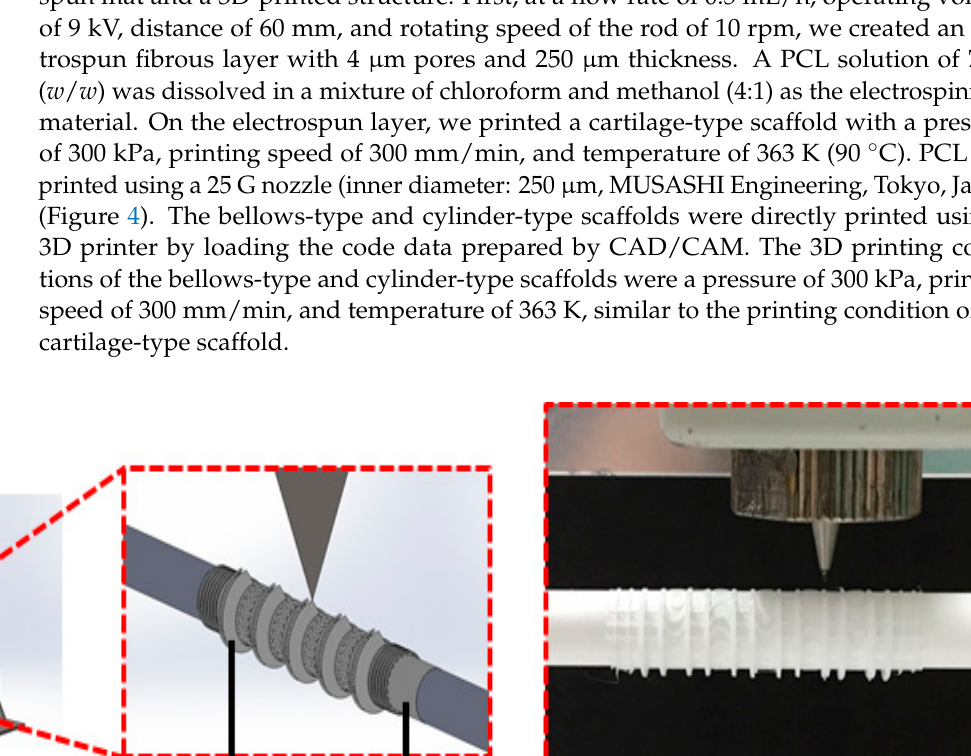
5 of 16 Figure 3. Design and 3D printing data for three types of trachea scaffolds: ( A ) cartilage type, ( B ) bellows type, and ( C ) cylinder type. 2.5. Simulation Test Cylinder type, bellows type and cartilage type scaffolds were designed using com- puter aided design (CAD) software (Solidworks 2017; Dassault Systemes, Vélizy-Villacou- blay, France). The simulations were done using the finite element method tool of Solid- works. Properties of the PCL material necessary for the simulations were obtained from the manufacturer’s data sheet. To evaluate the structural behavior of the designed scaf-